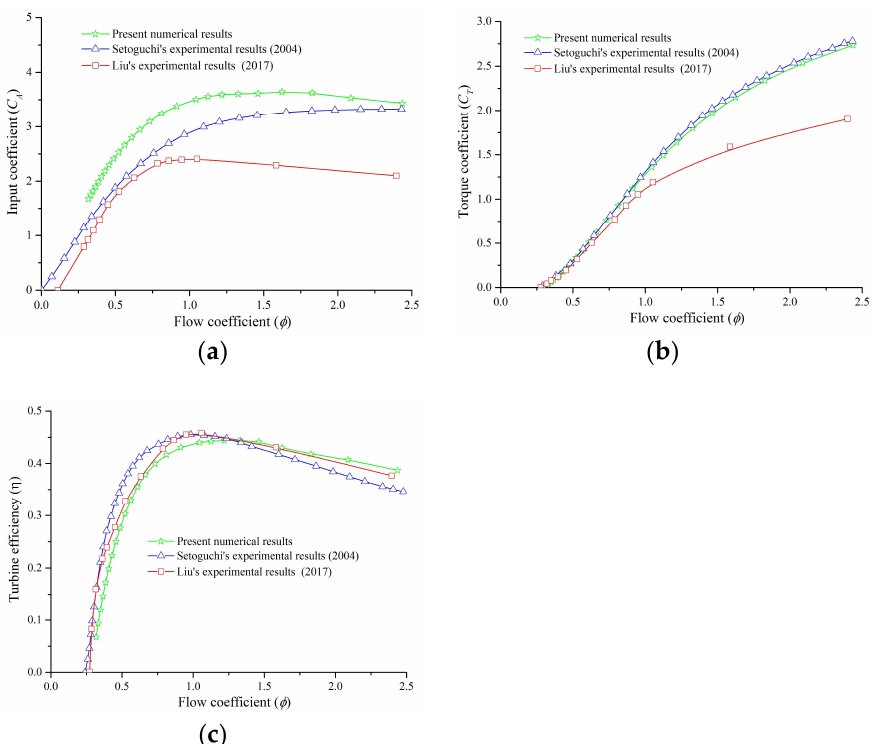
Figure 5. ( a ) Input coefficient ( b ) Torque coefficient and ( c ) Turbine efficiency for different flow